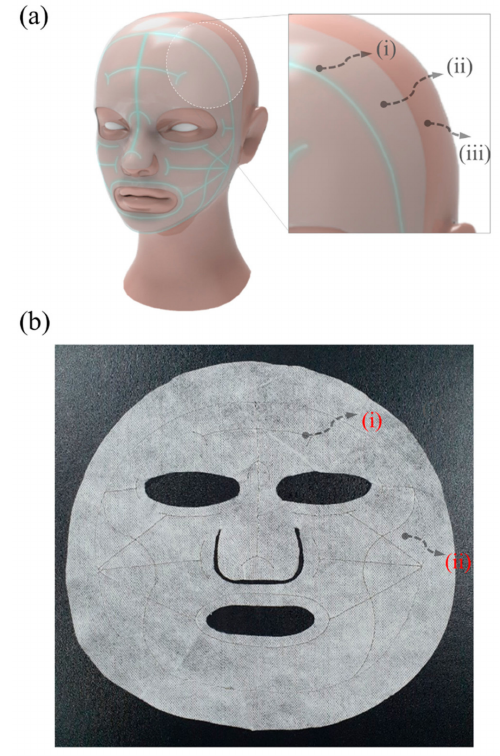
Figure 7. ( a ) Application of facial mask with an embedded electrode, and ( b ) produced electric facial mask. The arrows in the enlarged part indicate the ( i ) Ag yarn, ( ii ) nonwoven felt, and ( iii ) facial